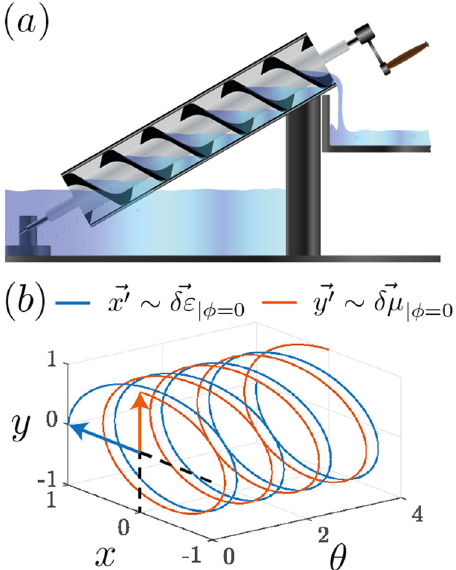
Fig. 1 Illustration of an optical Archimedes ’ screw. a A mechanical Archimedes screw carries fl uids from a lower to a higher ground 56 . b An optical screw is a medium whose permittivity and permeability tensors are ! ! modulated such that the principal axes δε and δμ of their modulation describe two helices. Furthermore, in our model we allow for a dephasing 2 ϕ between the two modulations. For zero-dephasing ( ϕ = 0), at ! ! θ = gx − Ω t = 0, δε points along the x -axis while δμ points along the y -axis. For fi nite dephasing ϕ ≠ 0 the two modulations are shifted forward and backward in space-time by 2 ϕ , so that their total phase difference is 2 ϕ